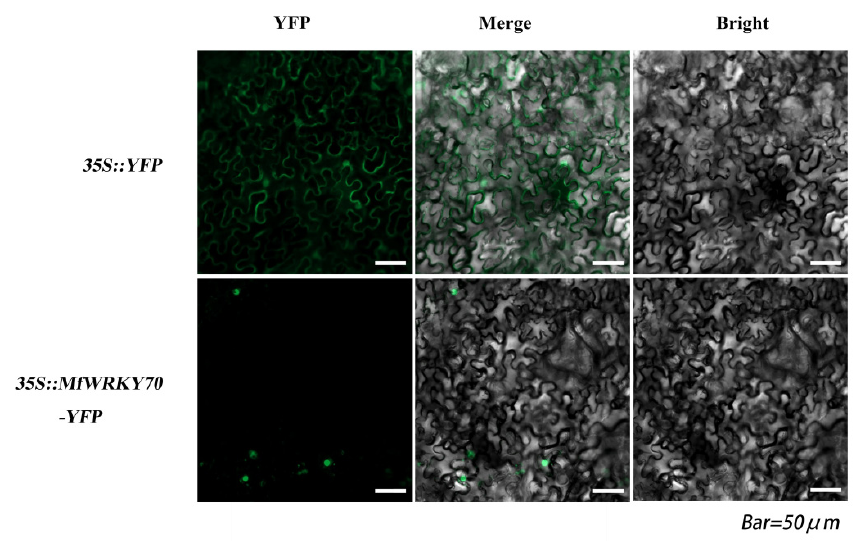
Figure 2. Subcellular localization of MfWRKY70-YFP fusion proteins. Fluorescence of yellow fluorescent protein (YFP) was detected in the nucleus of tobacco cells expressing MfWRKY70-YFP, and tobacco cells transformed with 35S::YFP was used as a control (upper lane).